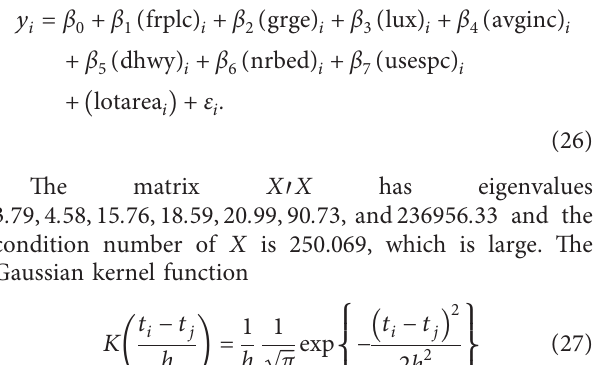
Table 2: The estimated MSE of the estimators when n � 50.